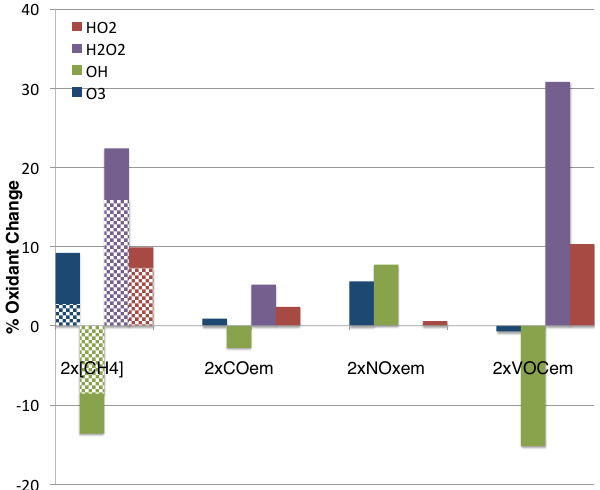
Figure A1. Sensitivity of oxidant concentrations to a doubling in [CH 4 ] or emissions of CO, NO x , or VOCs relative to a simulation of preindustrial oxidant chemistry (Sofen et al., 2011). Each bar rep- resents the fractional change in Southern Hemisphere extratropical lower tropospheric ( ≤ 2km) oxidant concentration. The checkered segment of the CH 4 sensitivity study indicates the fraction of the oxidant changes for which CH 4 -derived CO is